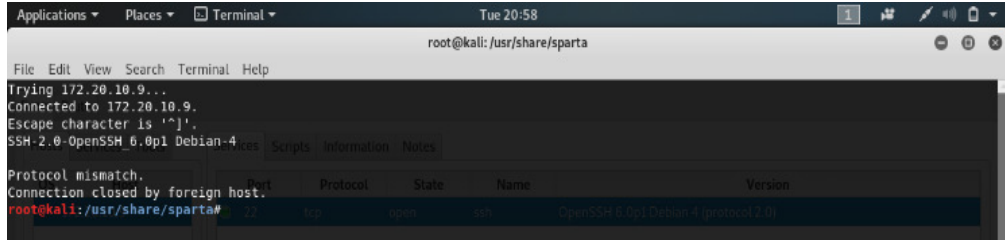
Fig. 15: Open with telnet attack (protocol mismatch)